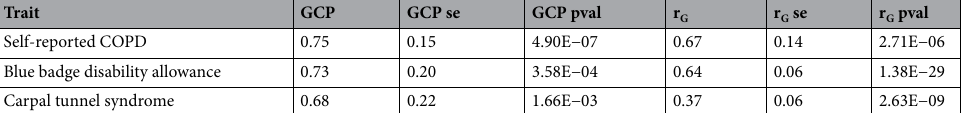
Trait GCP GCP se GCP pval r